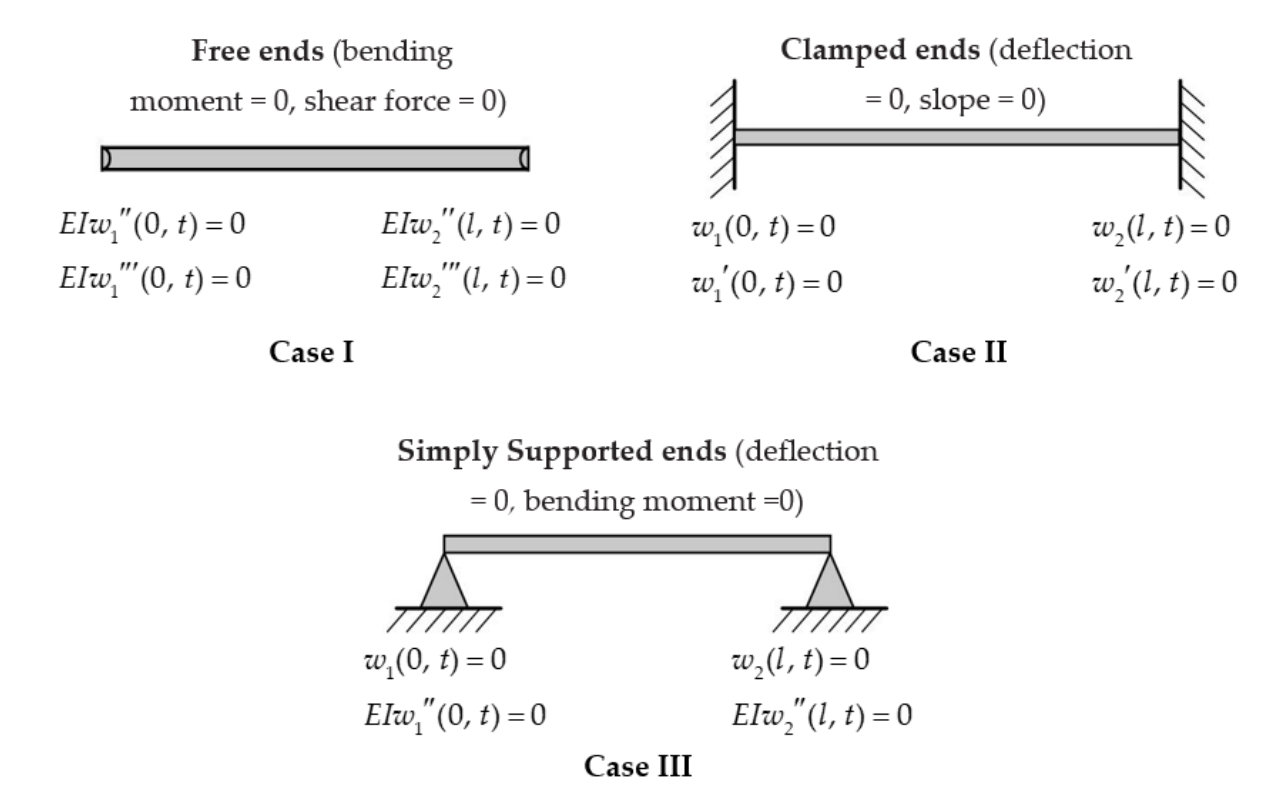
Figure 1. Different boundary conditions for a beam without mass system.